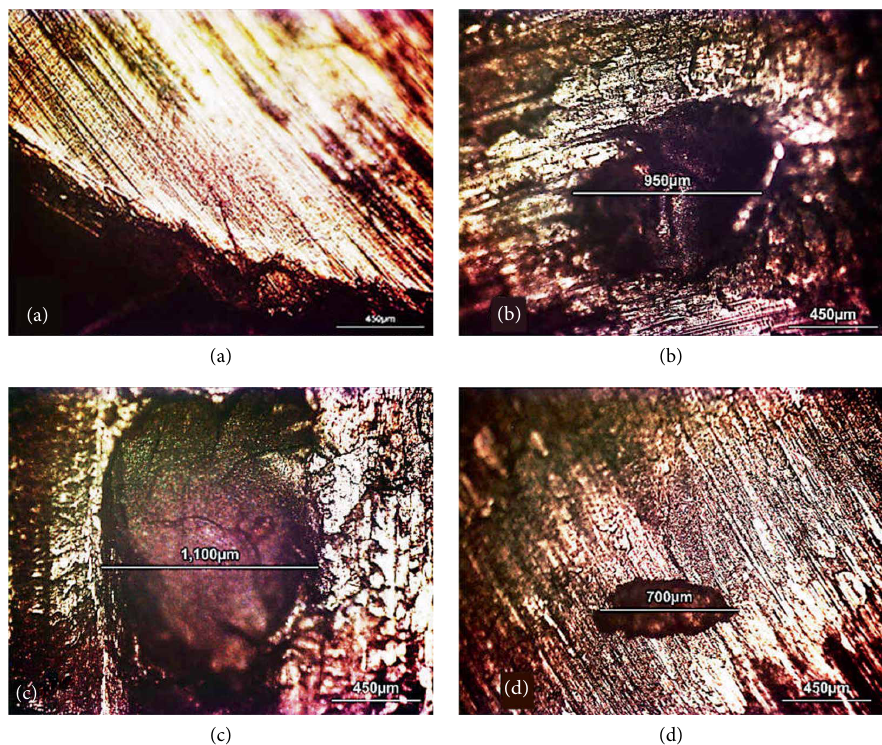
Figure 13: Optical micrographs showing wedge cutting edge and pit formation: (a) wedge cutting edge in NO, (b) Pit in Pure NO, (c) 0.25% GNPs-NO, and (d) 0.5% GNPs-NO.